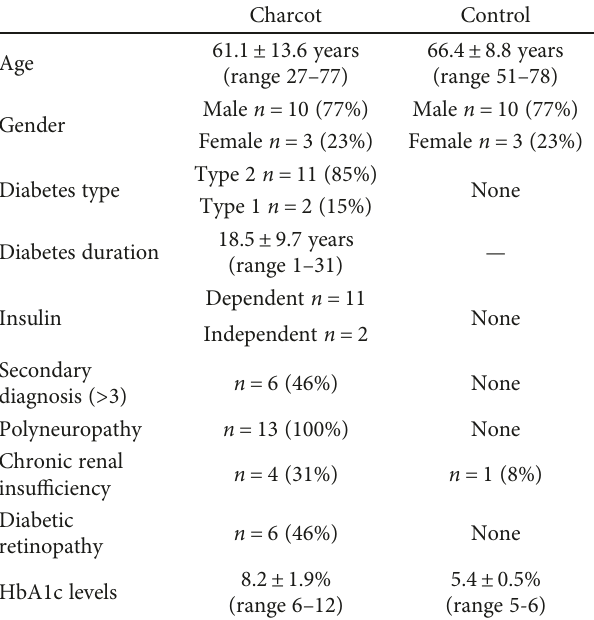
Table 1: Demographic data of included participants.